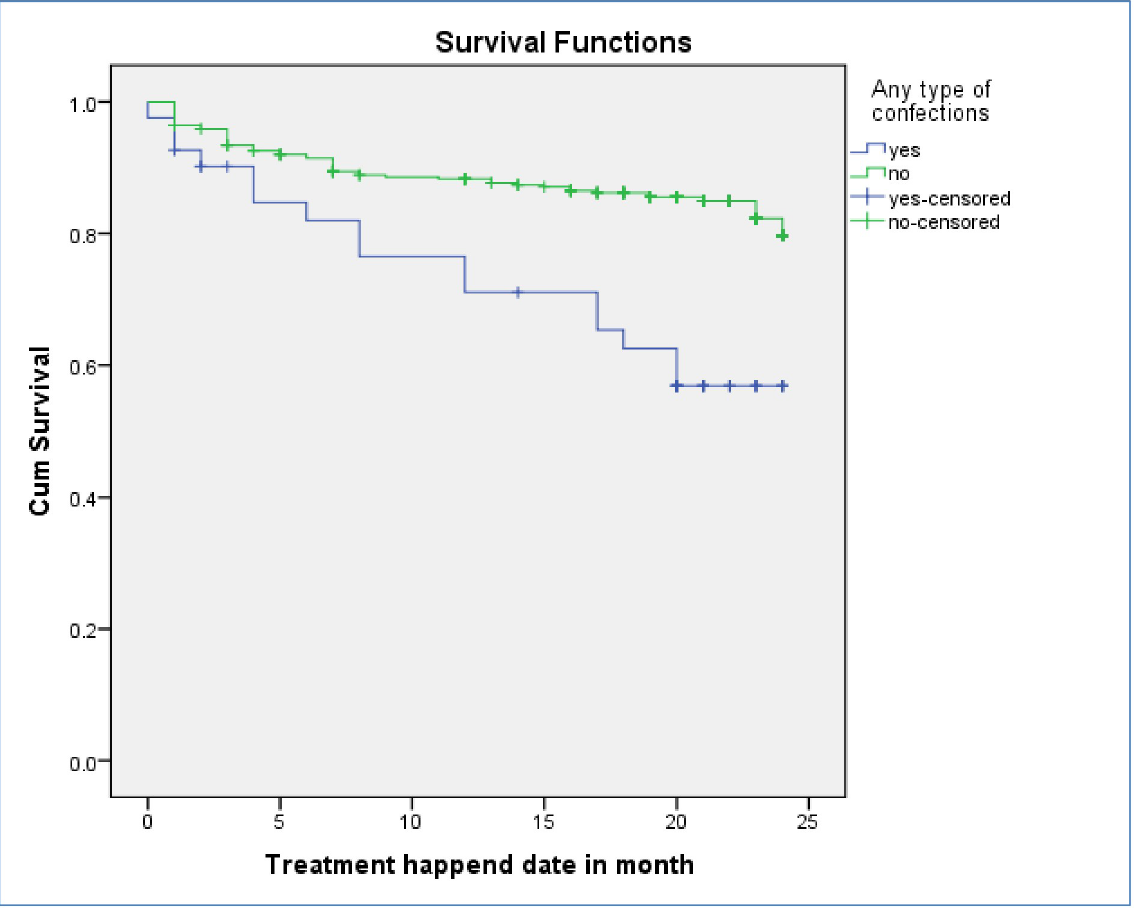
Fig 5. Kaplan–Meier survival estimate for mortality of drug resistance tuberculosis infected patents for patients with co morbidity and without co morbidity in Oromia region, Ethiopia,